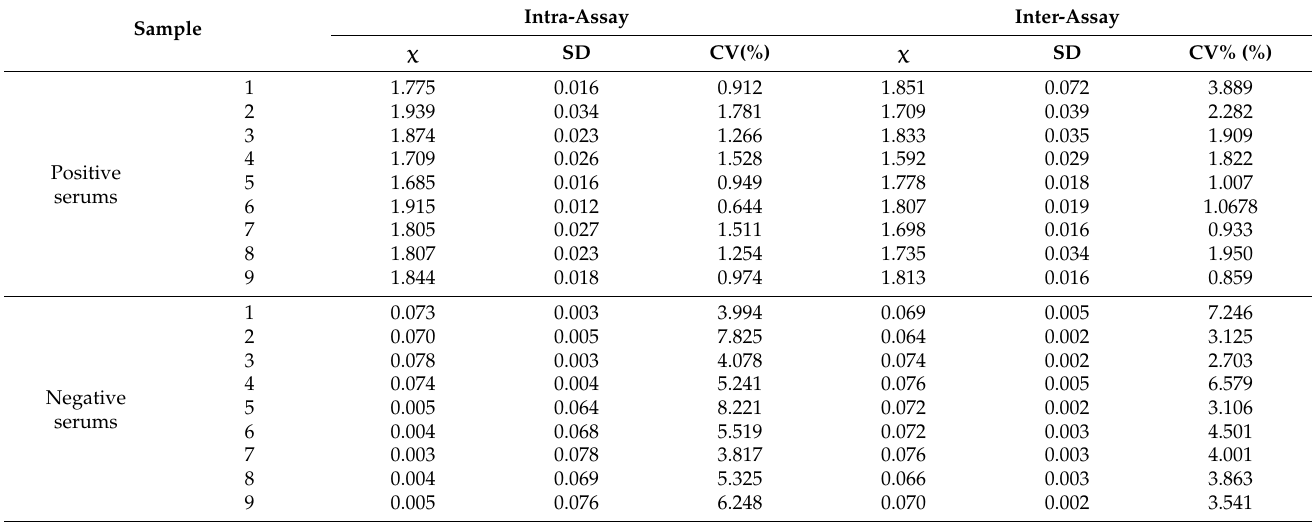
Table 1. Determination of coefficient of variation (CV) from 18 serum samples.